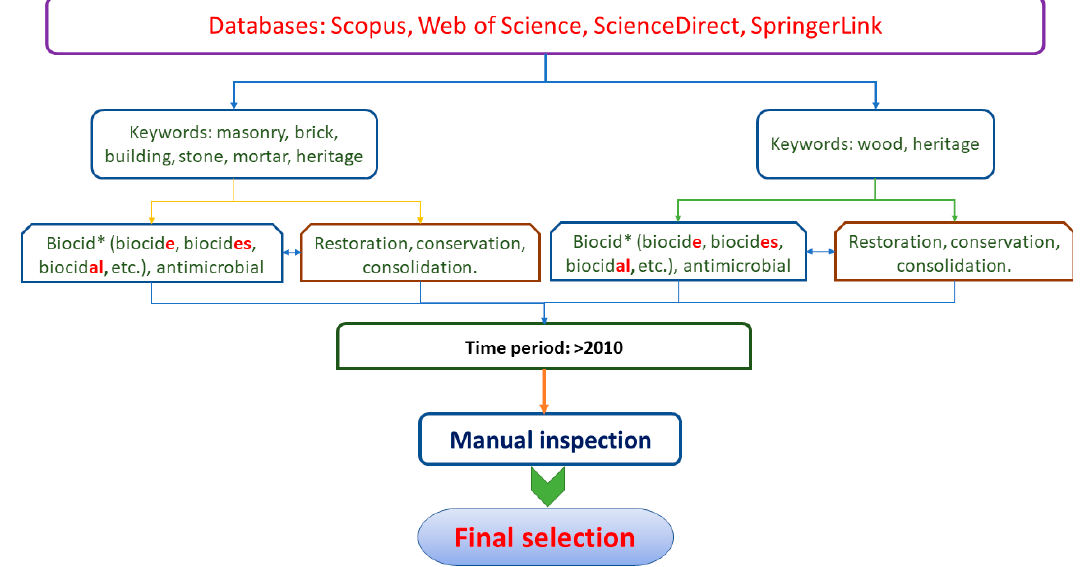
Figure 2. General procedure followed for the selection of articles to be included in the present review.